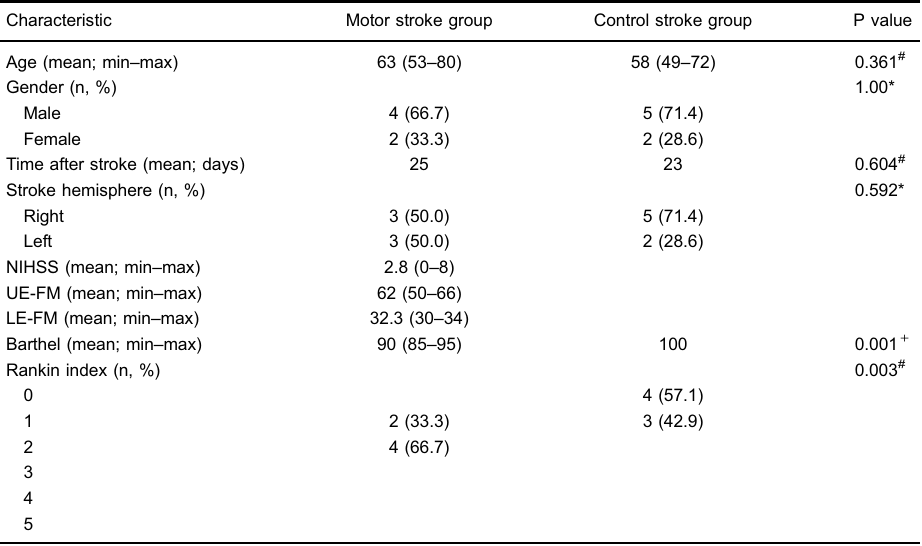
Table 2. Demographic and clinical characteristics of the motor stroke and control stroke